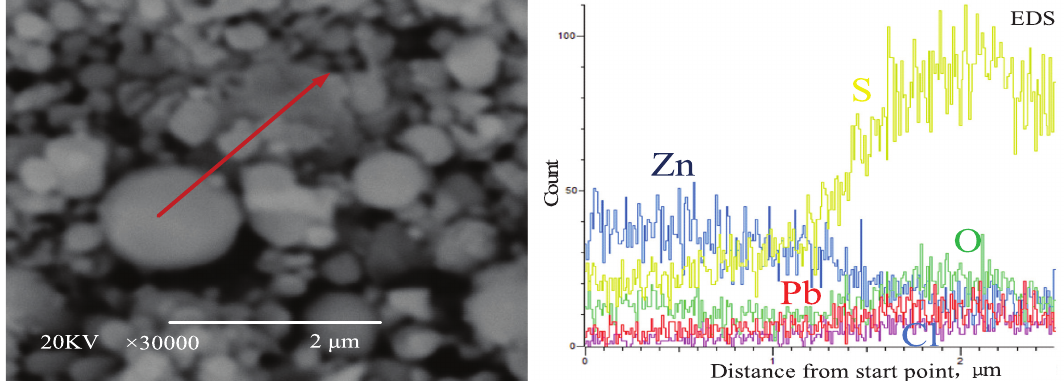
Fig. 2: EDS line scanning results of zinc oxide dust sample (red